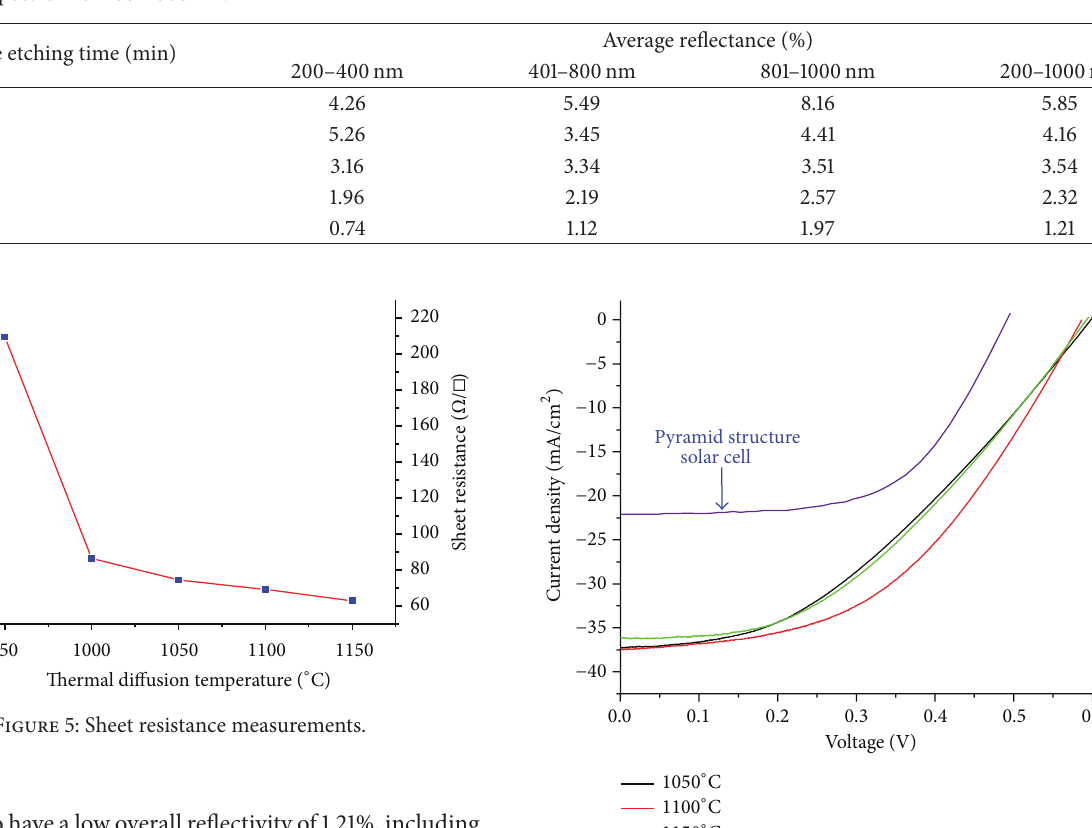
Table 3: Average reflectivity of the two-stage MAE fabricated micronanohybrid structures subjected to a first-stage processing time of 30 sec for the light spectrum of 200–1000 nm.